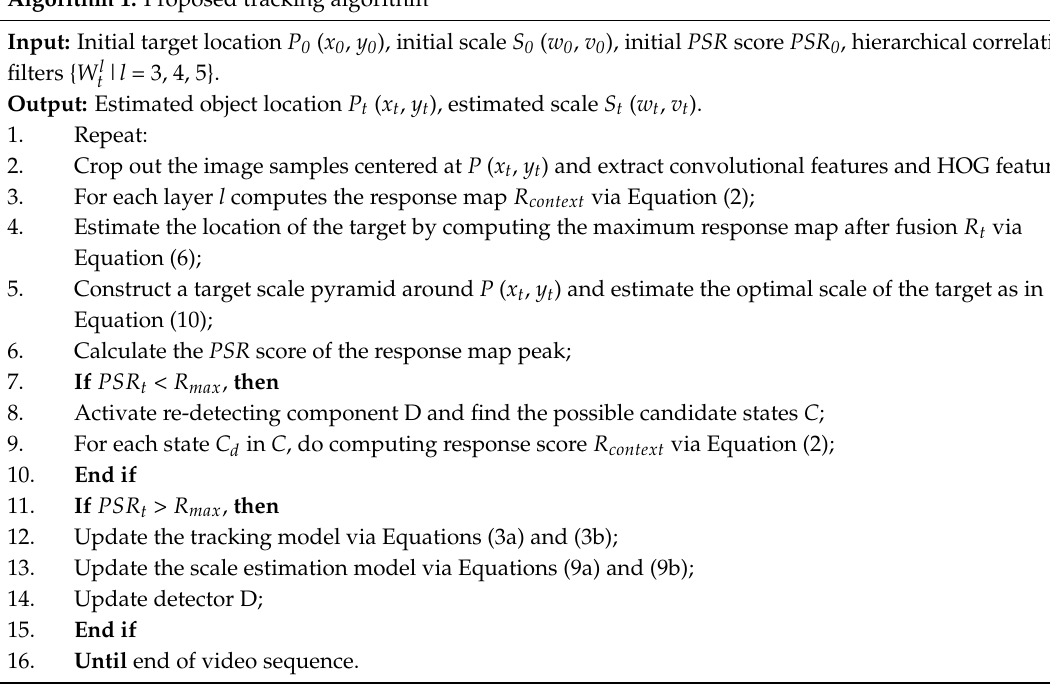
Algorithm 1. Proposed tracking